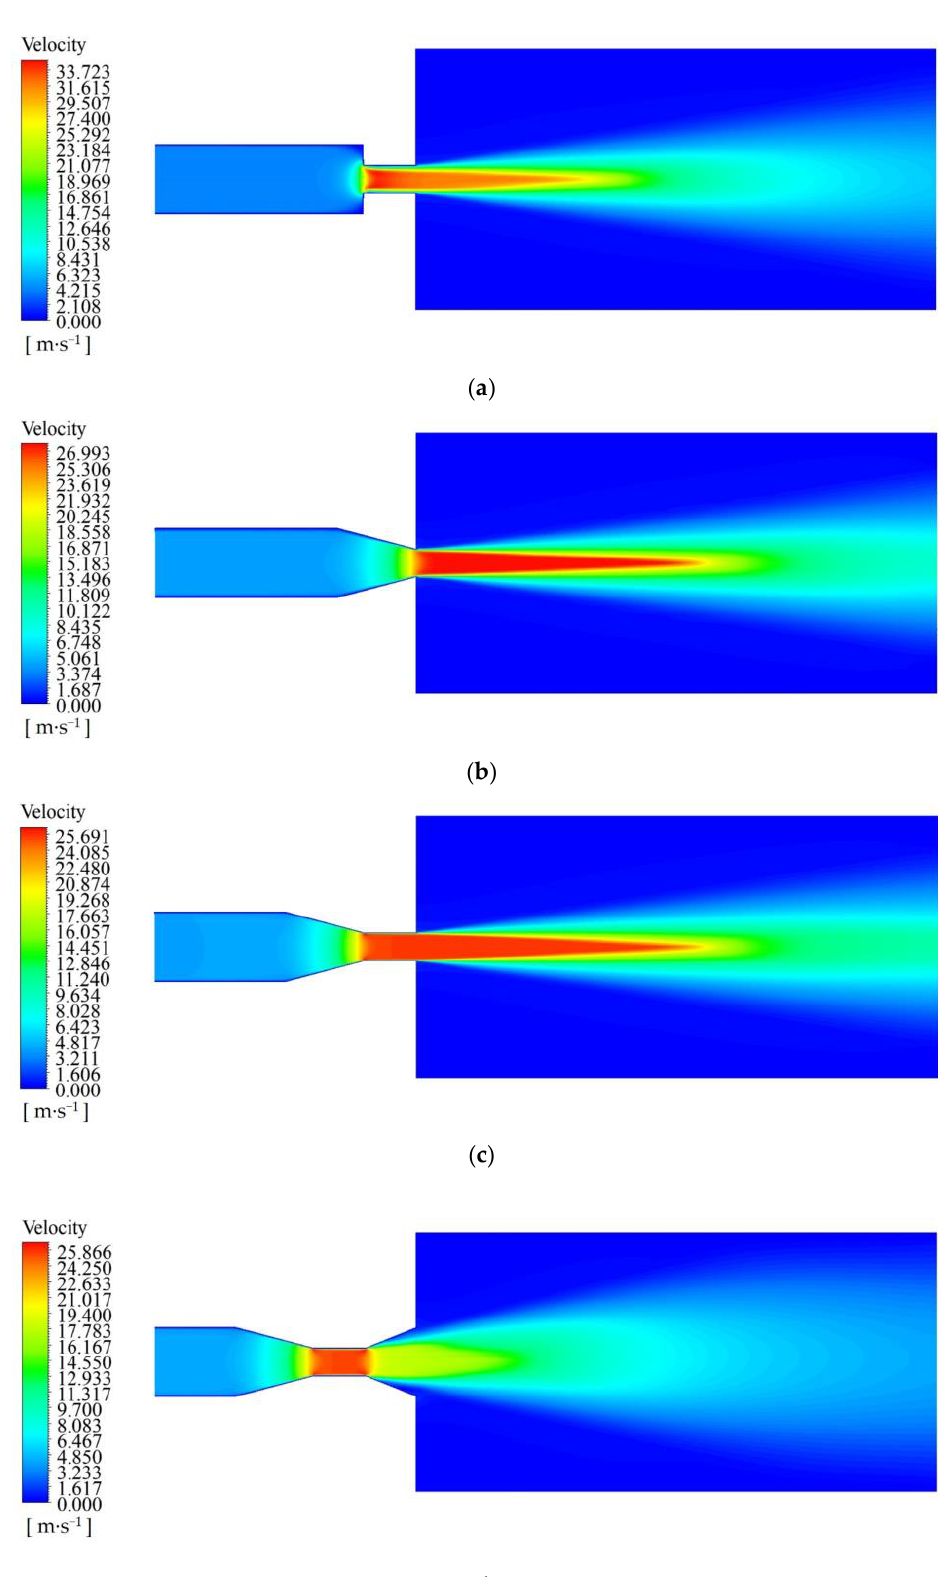
Figure 6. Four types of nozzle velocity clouds. ( a ) Cylindrical nozzle velocity cloud, ( b ) Conical nozzle velocity cloud, ( c ) Conical-cylinder nozzle velocity clouds, ( d ) Diffusion nozzle velocity cloud.